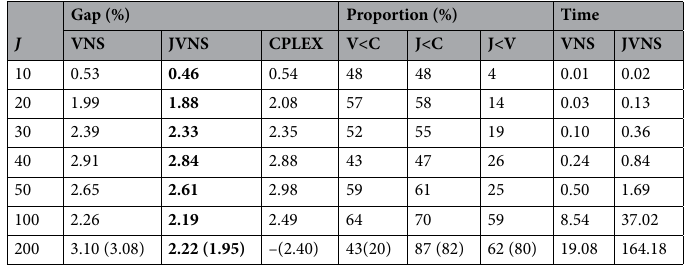
Table 4. Comparison between VNS, JVNS, and CPLEX. Significant values are in